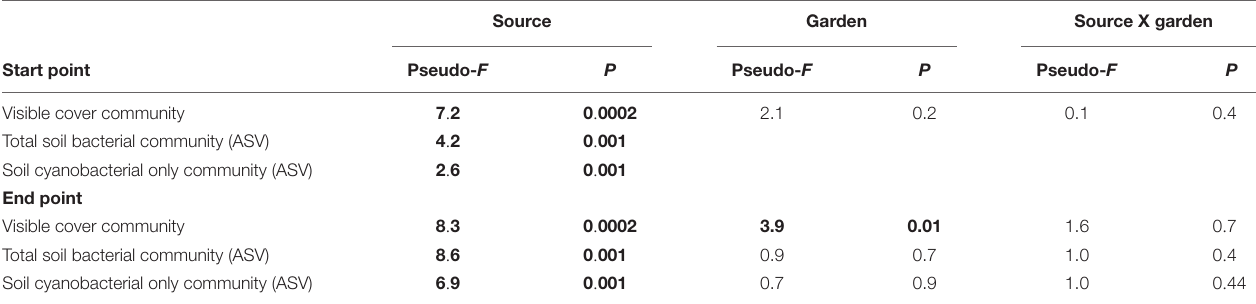
TABLE 2 | Results of PERMANOVA on visible and soil communities at the start and end